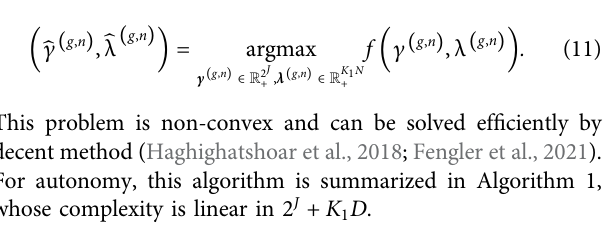
FIGURE 2 | Block diagram of transmitter in the mixed massive random access.